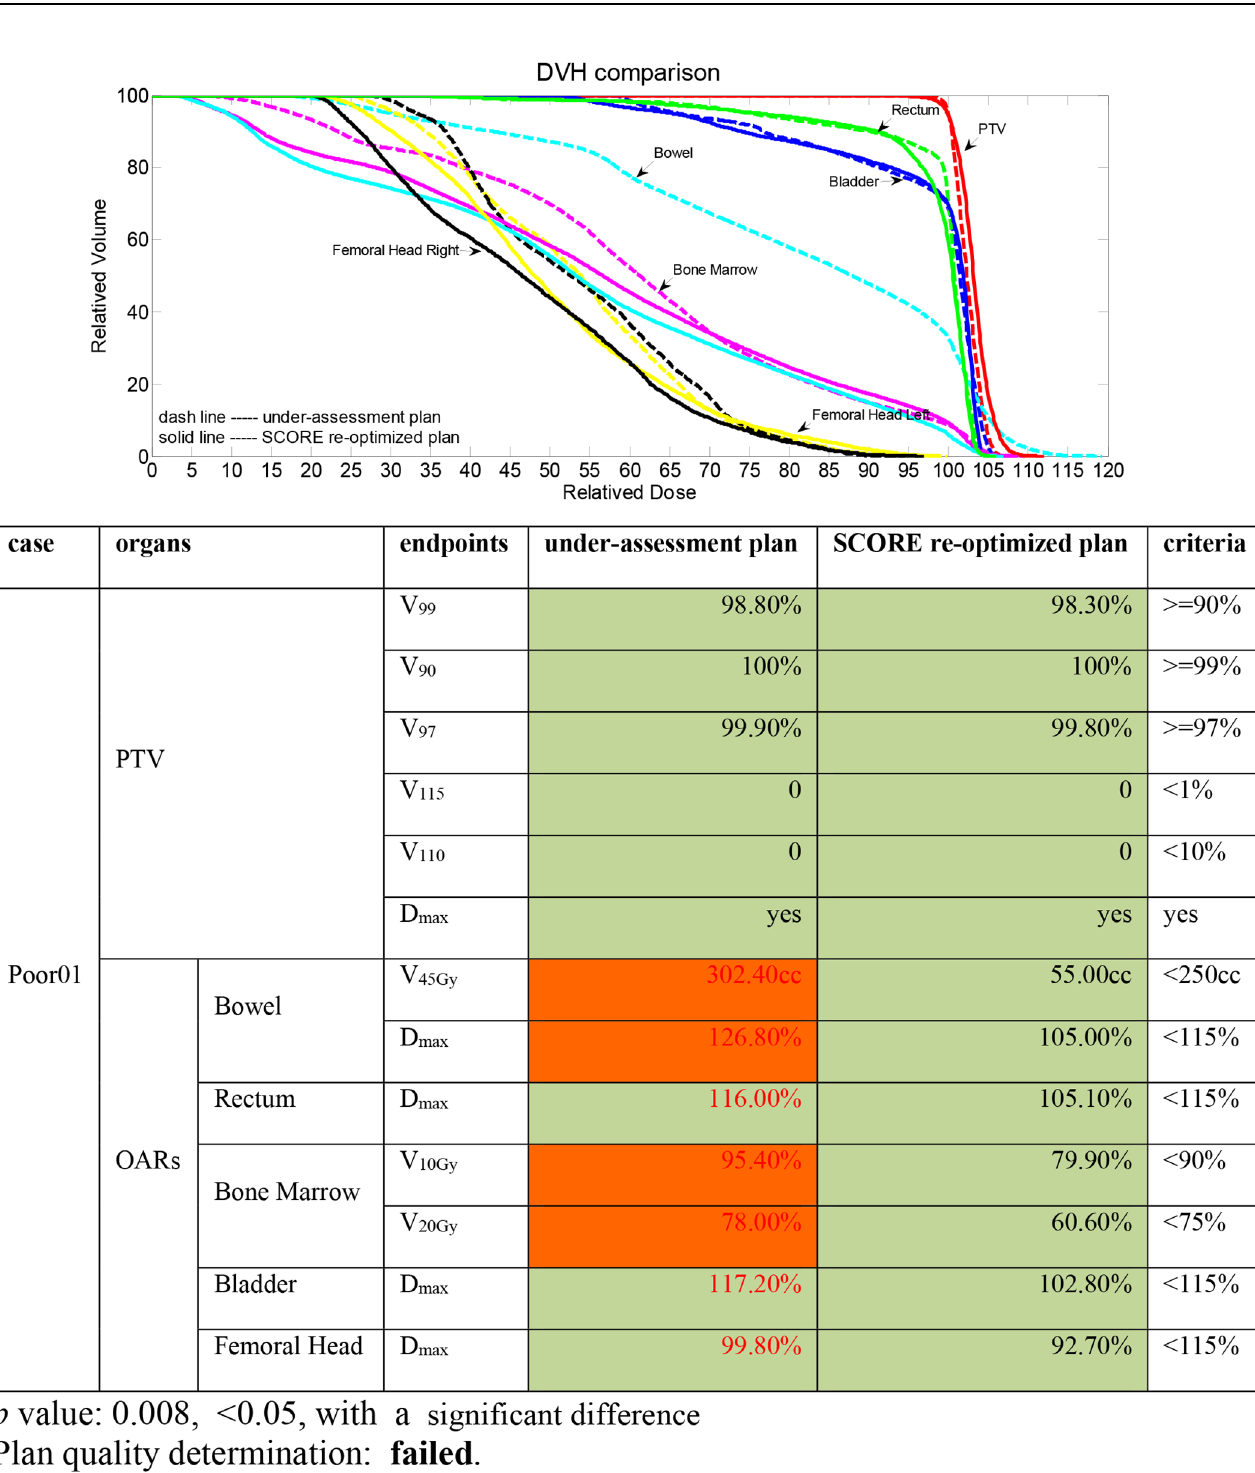
Fig 4. A QC report example for a poor-quality